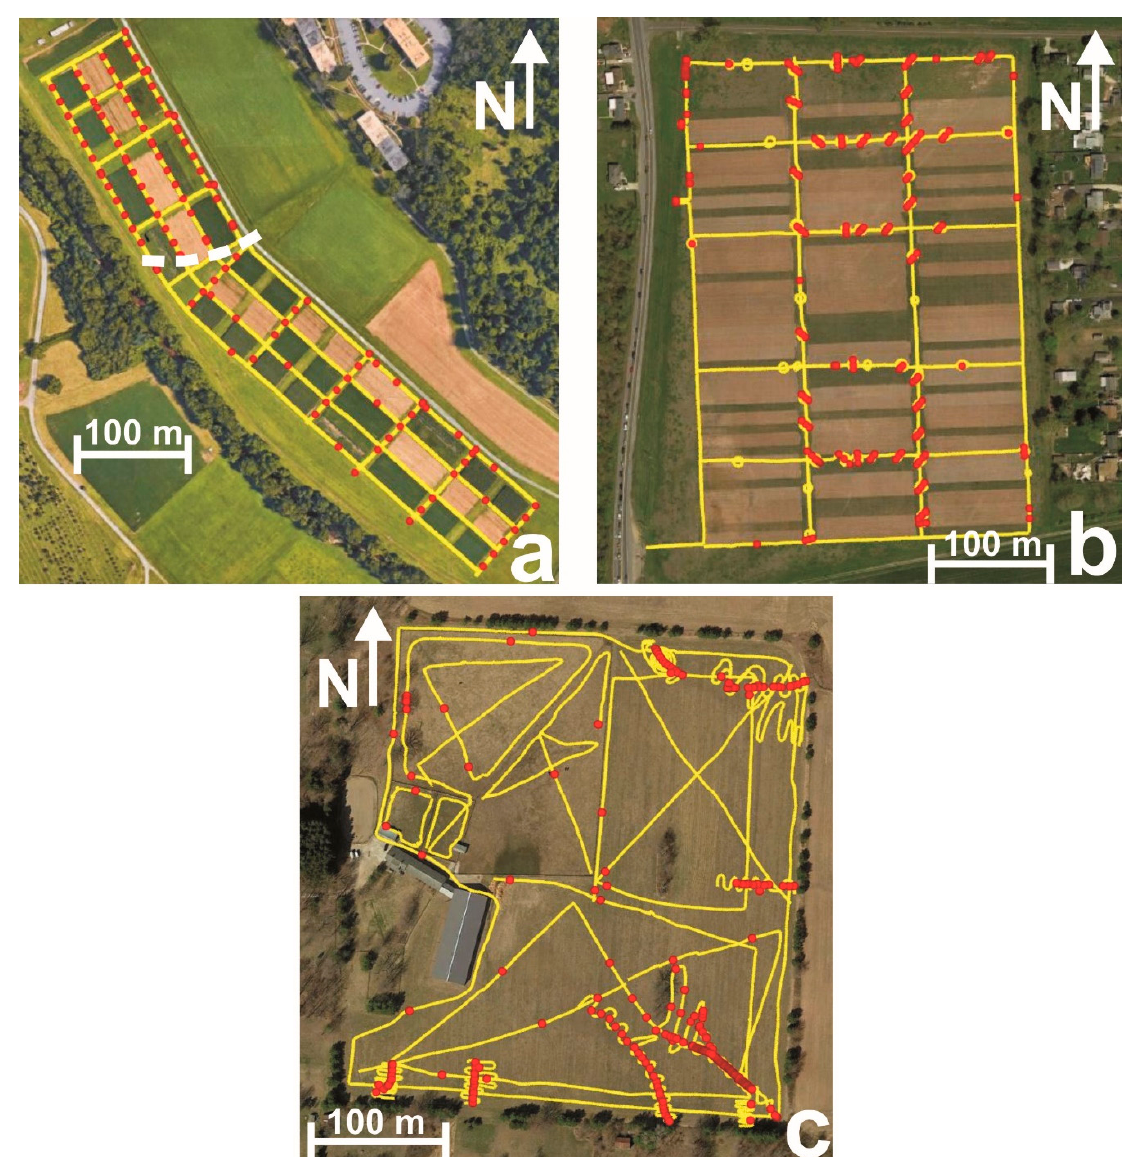
Figure 7. GPR measurement transects (yellow lines) and potential drainage pipe locations (red dots):